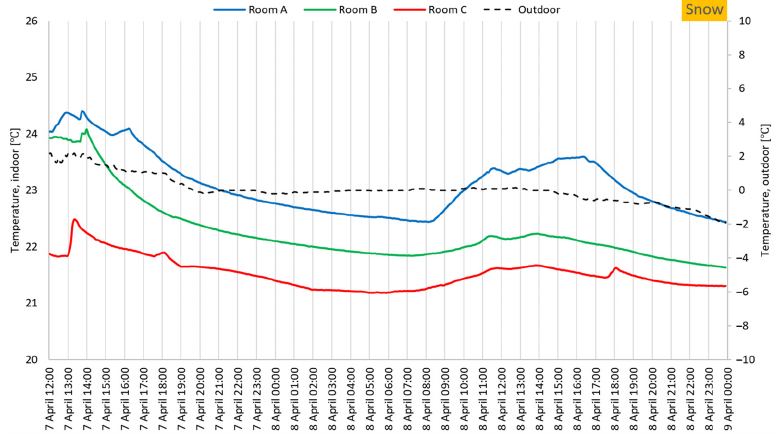
16 of 26 Figure 17. Comparison of indoor and outdoor RH and symbols of weather, with the indoor RH of the three rooms shown on the left axis and the outdoor RH on the right axis. Figures 18–23 show temperature and humidity indoors and outdoors on selected days when it was snowing, cloudy, and sunny. Figures 18 and 19 show 1.5 days when it was snowing outside. During this period, there were staff in room A until 16:15 on the first day and staff from 8:10–16:20 on the second day. There were no staff or curtains in room B, but one blind was down. In room C, there were no curtains until 17:40 on the first day, and then short curtains were drawn, and there was no staff presence except from